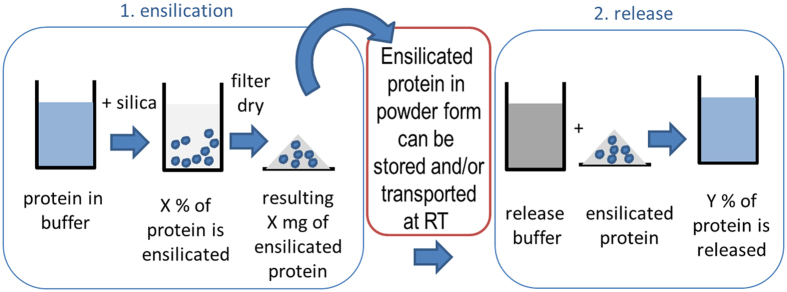
Ensilication and subsequent release methods schematic.